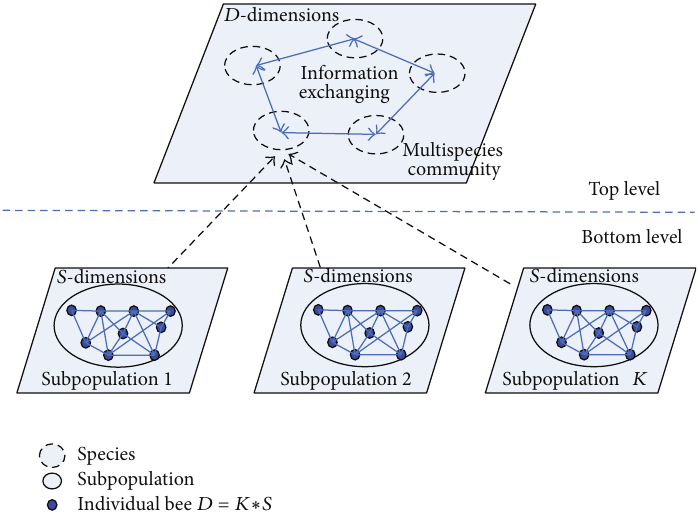
Figure 1: Hierarchical optimization